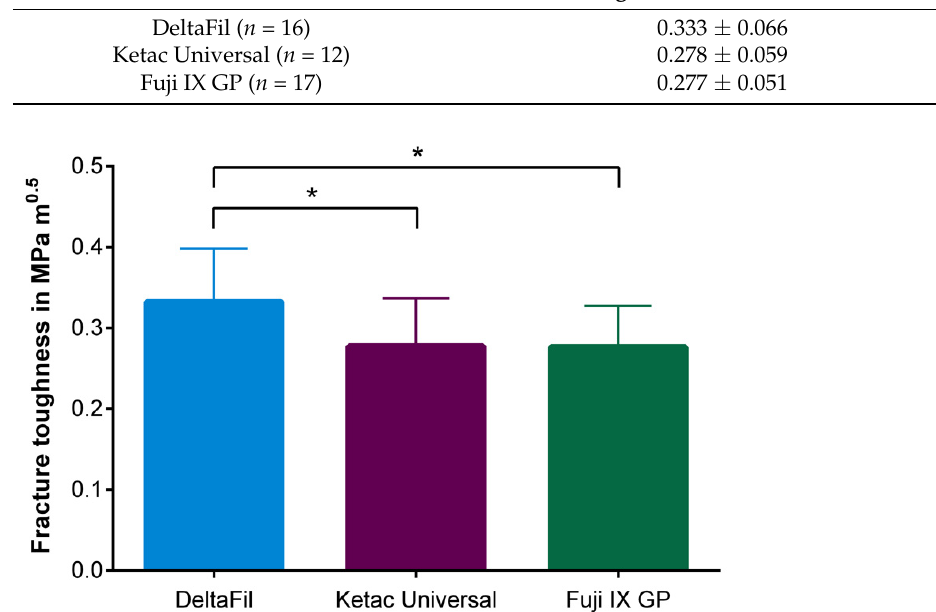
Figure 6. Fracture toughness of the investigated GICs measured using a notchless triangular prism testing rig. The fracture toughness of DeltaFil was significantly higher compared to Ketac Universal and Fuji IX GP (‘*’: p ≤ 0.05). The error bars represent the standard deviations of the measured data.